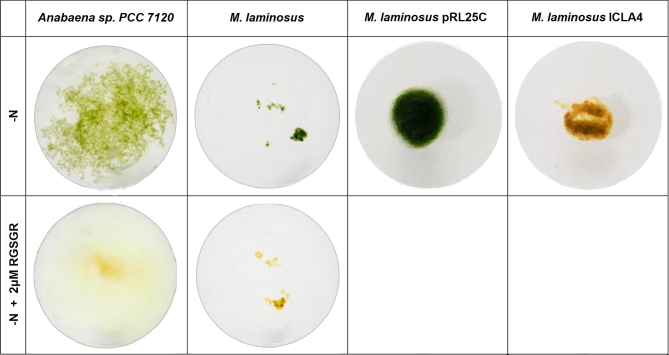
Effect of pentapeptide RGSGR and PatS on growth of Anabaena sp.
PCC 7120 and M. laminosus under nitrogen deprivation. Addition of
RGSGR to the growth medium (second row) leads to cell death and bleaching. Expression
of patS in M. lamnosis (ICLA4) shows a similar
effect when grown in nitrate-free media (last column). The control strain with pRL25C
was able to grow under nitrogen depletion condition. Photographs were taken 12 days
after inoculation.